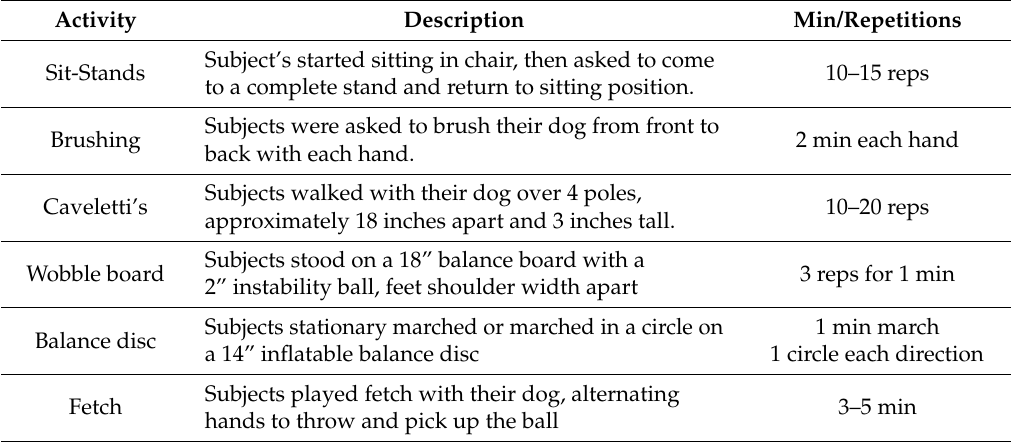
Table 1. Description of the physical activities completed each week during the intervention (Caveletti’s, wobble board and balance disc were substituted with walking the dog in the homework phase of the weekly